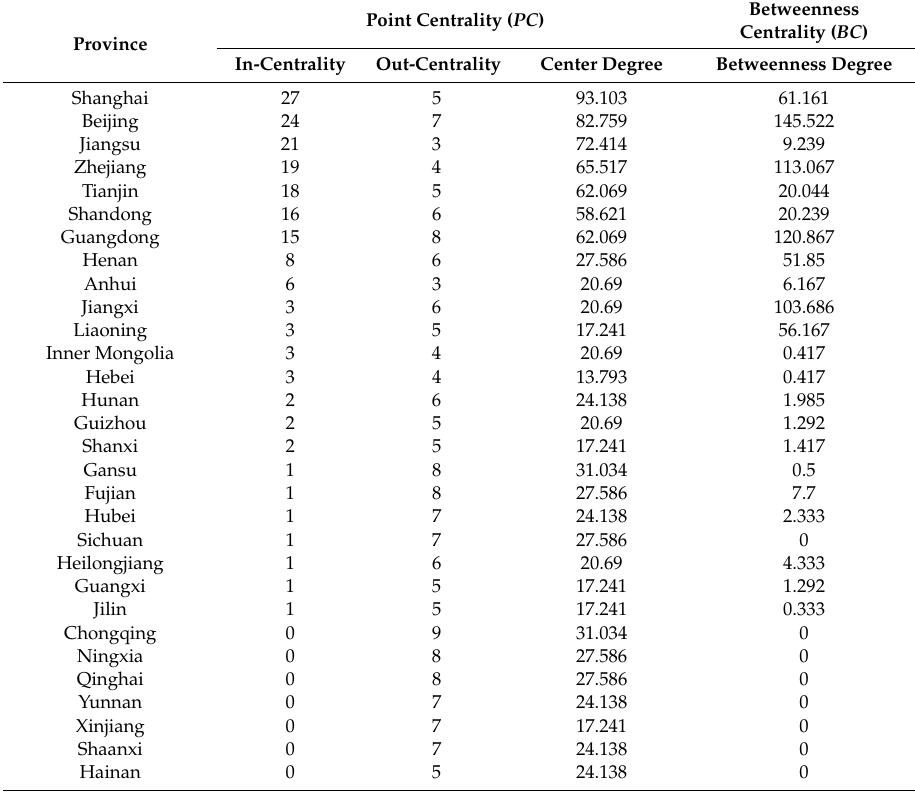
Table 6. The centrality analysis of the ANTCE.